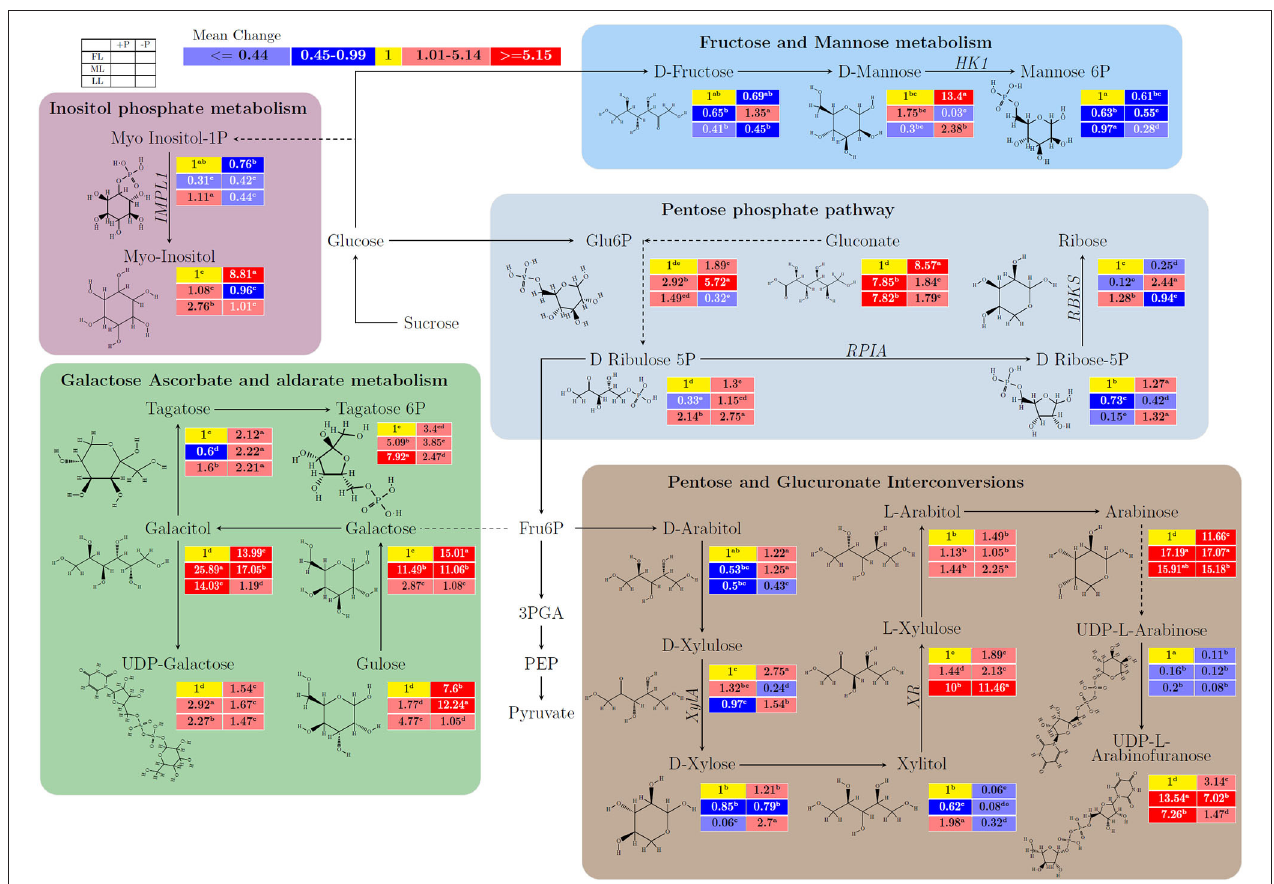
FIGURE 2 | The light and P interactive effect on the biosynthesis of carbohydrates and/or related anaplerotic pathway metabolites to carbohydrates in young shoots of Fengqing cultivar measured by two-dimensional gas chromatography coupled to time-of-flight mass spectrometry (GC × GC–TOF/MS). The mean of each metabolite followed by a different letter in the heatmap table indicates a significant difference. In the heatmap, red boxes represent the value > 1 and are separated into dark red and mild red by the mean value of the figured pathway data ( > 1) and subsequently < 1 with blue color and mean value separated into mild blue and dark blue from figured pathway data ( < 1). The yellow box represents the normalization value. The blank table in the legend shows the position of the mean P and light treatment value of the metabolites.